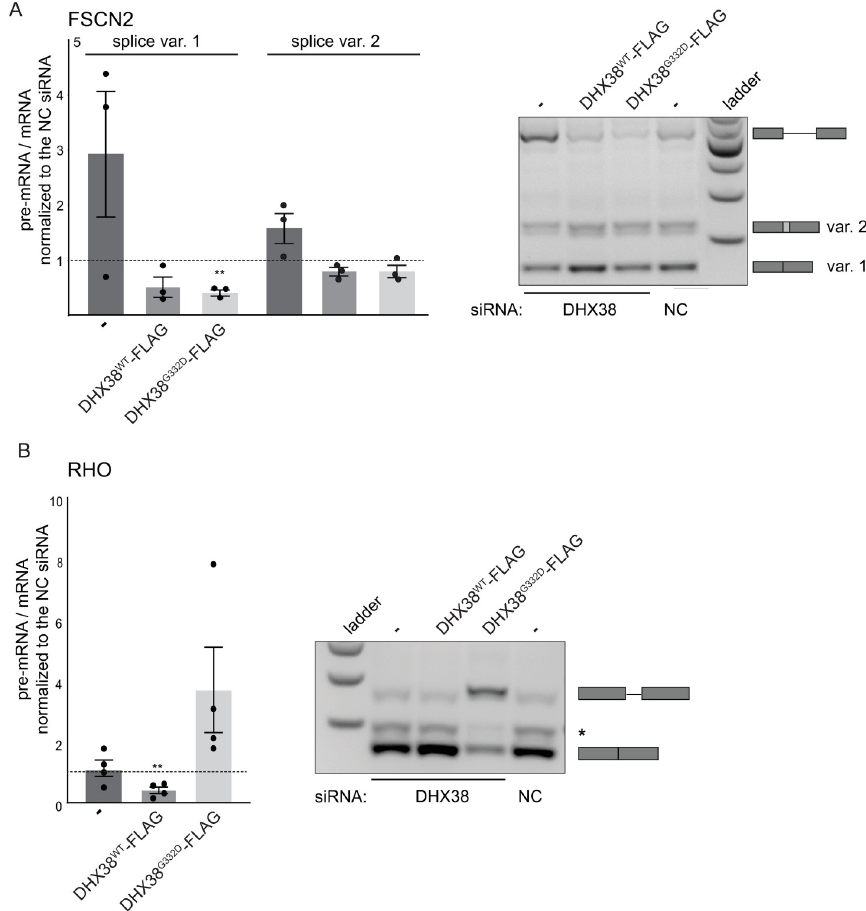
Fig 3. DHX38 is important for splicing of retina gene-derived reporters. Splicing of (A) FSCN2-derived reporter and (B) RHO-derived reporter was analyzed after DHX38 downregulation and after expression of siRNA-resistant DHX38 WT -FLAG and DHX38 G332D -FLAG proteins. Normalized ratio of pre-mRNA/mRNA from at least three independent experiments is shown in a graph together with the mean and SEM. Statistical significance was assessed by two-tail unpaired t-test ( �� indicates p � 0.01). Representative gels are shown. � next to RHO gel marks an unspecific